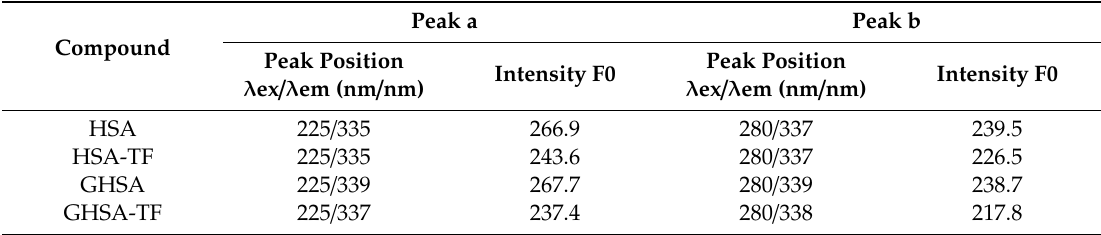
Three-dimensional fluorescence spectral characteristics of HSA / GHSA and TF–HSA / GHSA systems.